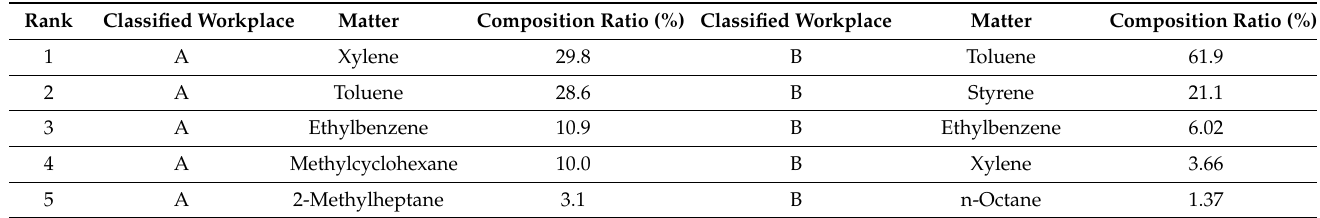
Table 8. VOCs composition ratio by business site as a result of measurement and